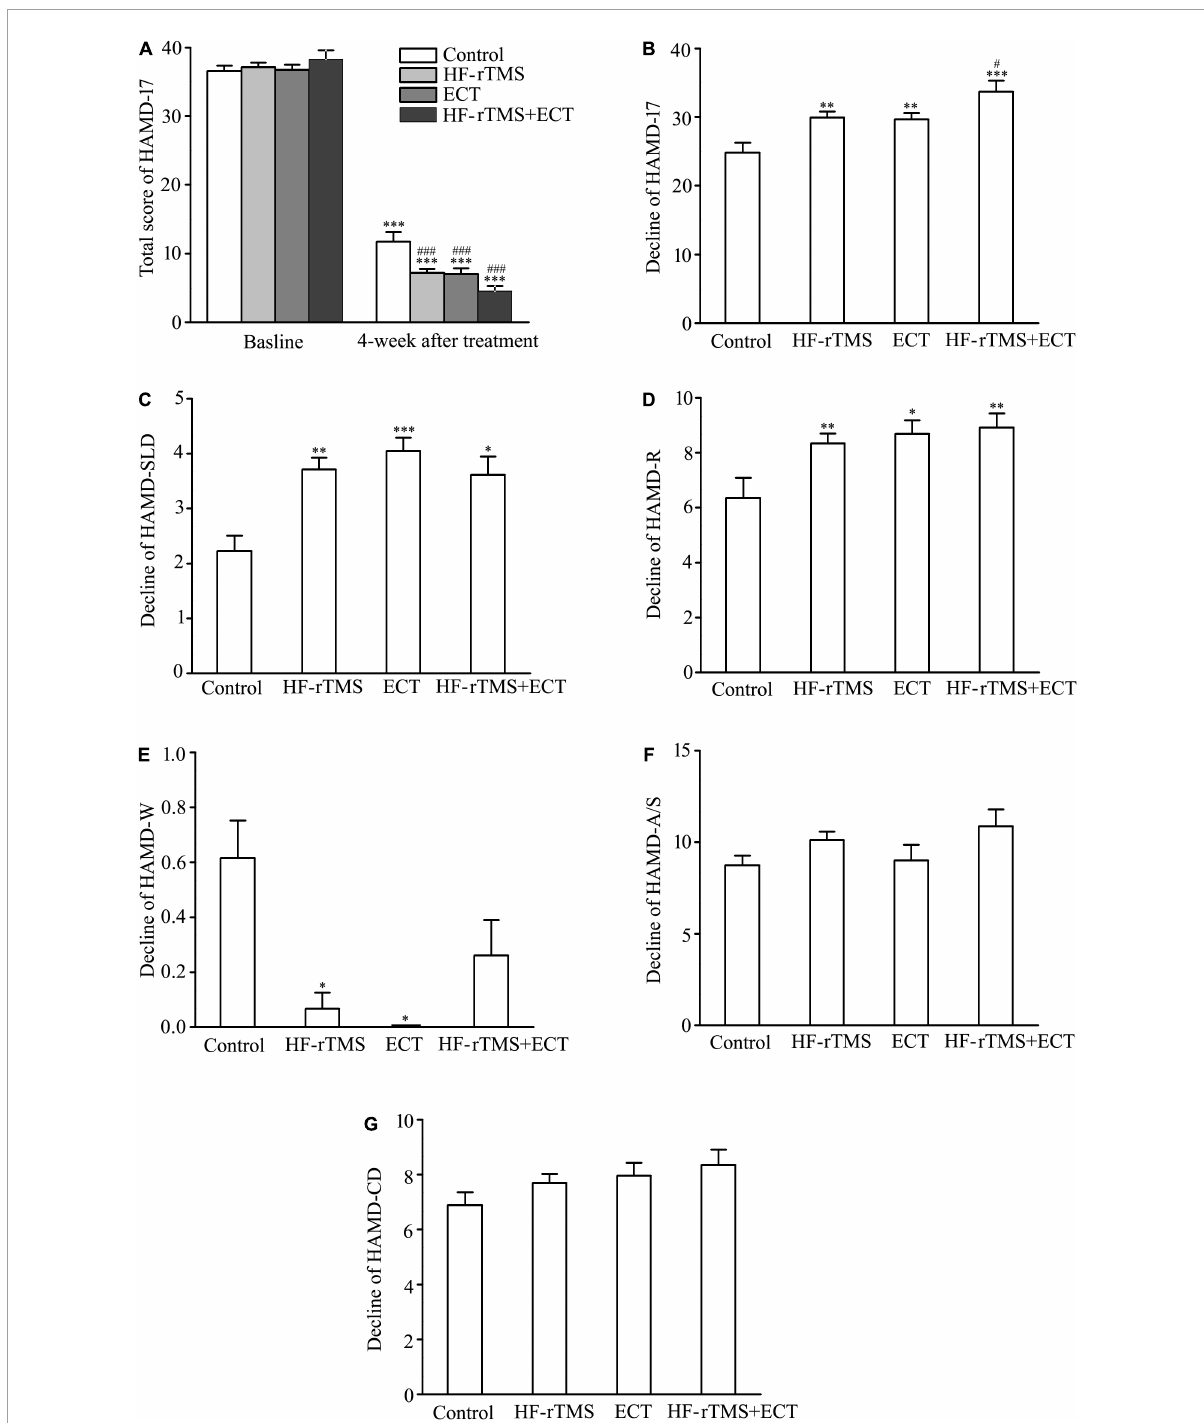
FIGURE2 Effect of non-invasive brain stimulation (NIBS) on depression scores measured with HAMD-17 at baseline and 4-week after treatment. (A) Total scores of HAMD-17 at baseline and 4 weeks after treatment. ∗∗∗ p < 0.001, compared with baseline levels; ### p < 0.001, compared with control at 4-week after treatment. (B) Change in total scores of HAMD-17 from baseline to post-intervention at 4 weeks. ∗∗ p < 0.01, ∗∗∗ p < 0.001, compared with control; # p < 0.05, compared with HF-rTMS group. (C–G) Change in scores of five factors in HAMD-17; HAMD-SLD (C) , HAMD-R (D) , HAMD-W (E) , HAMD-A/S (F) , and HAMD-CD (G) . ∗ p < 0.05, ∗∗ p < 0.01, *** p < 0.001, compared with control (C–G) . Graphs show mean ±